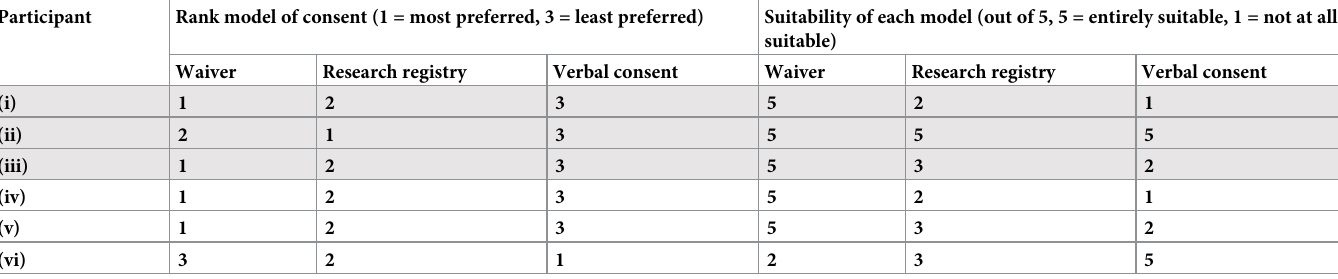
Table 2. Patient views on different models of consent for the research proposal. Participants (i) to (iii) were those who attended in person. First, participants were asked to rank the models of consent in order of preference (1 = most preferred, 3 = least preferred). Next, participants were asked to rate each model out of 5 for suitability (1 = not at all suitable; 5 = entirely suitable).